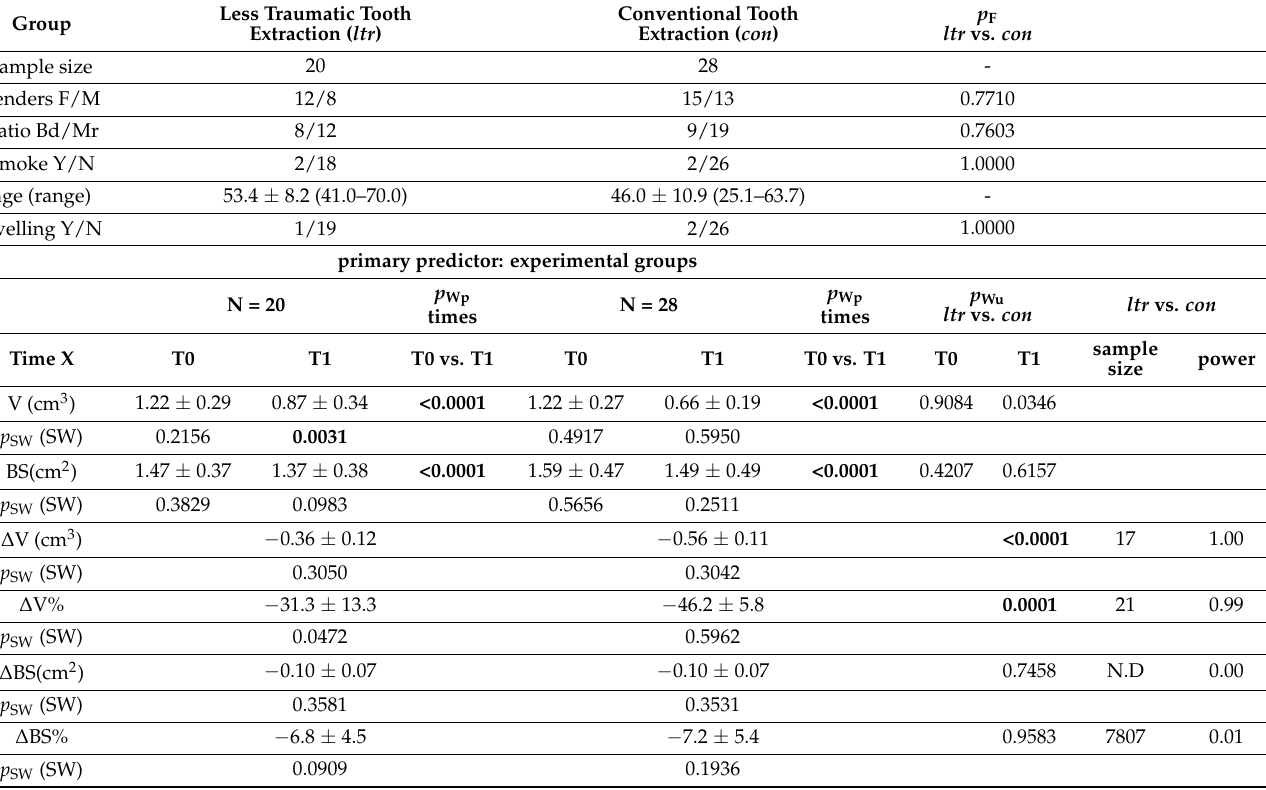
Table 1. Demographic data and homogeneity analysis between the two groups, less traumatic tooth extraction ( ltr ) and conventional tooth extraction ( con ), with descriptive variables (gender male/female, Y/N, and bicuspids/molars ratio, Bd/Mr and swelling events Y/N). The assumption of homoscedasticity was not met by Brown-Forsythe’s test for equality of variances F = 4.7130, df1 = 3, df2 = 92, p = 0.0042, and F = 4.6245, df1 = 3, df2 = 92, p = 0.0047 for overall volume variable and its buccal aspect. Bd, bicuspid; Mr, molar. Anatomical and outcome variables at baseline (T0) and at 4 months (T1, when the site was healed): volume of the alveolar ridge or V, basal surface or BS, and outcome variables (alveolar ridge volume and basal change percentages, respectively, ∆ V% and